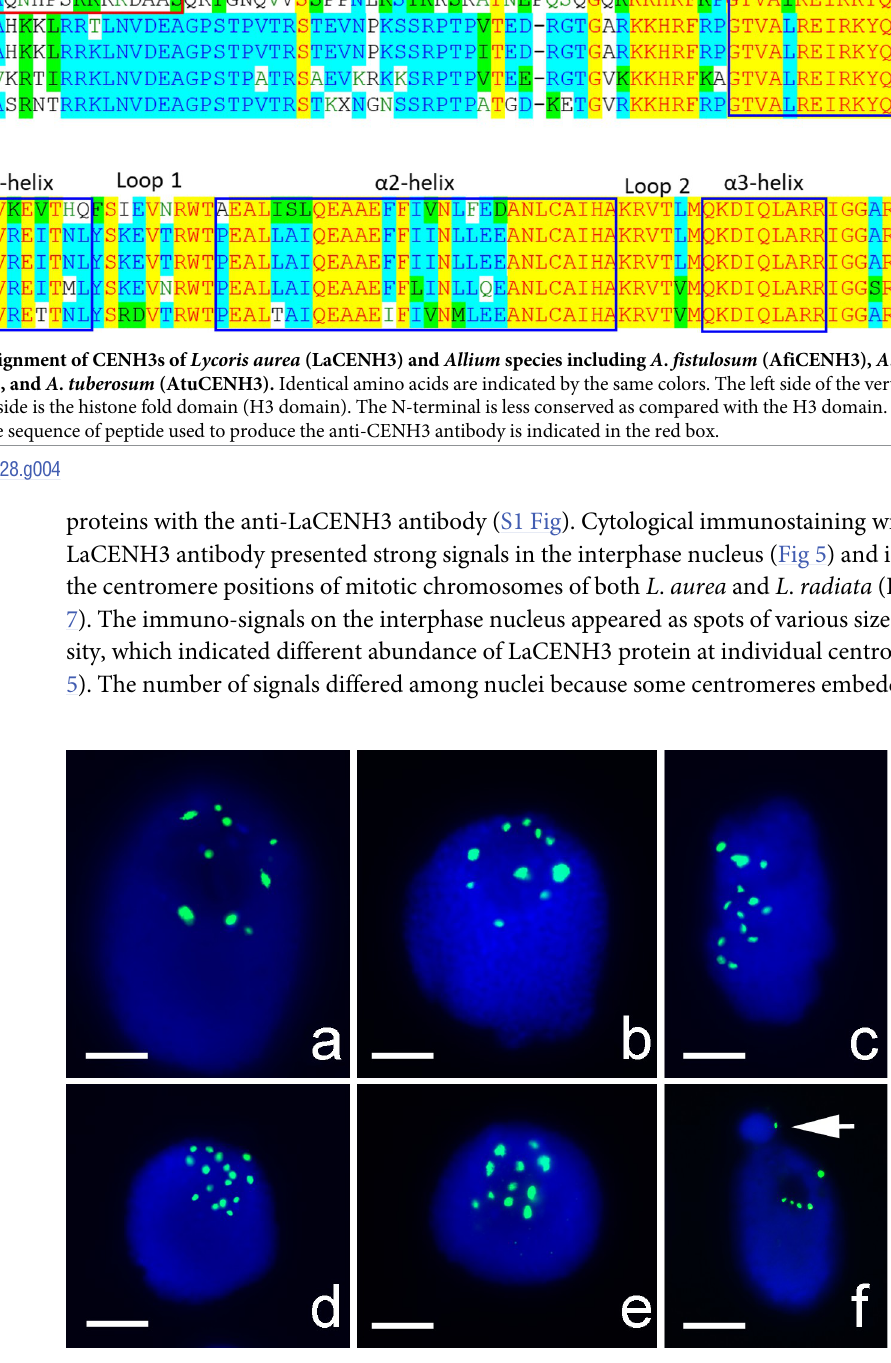
PLOS ONE | https://doi.org/10.1371/journal.pone.0258028 September 30,